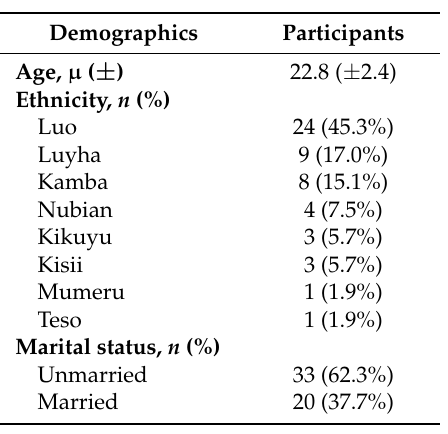
Table 1. Demographic information of the study